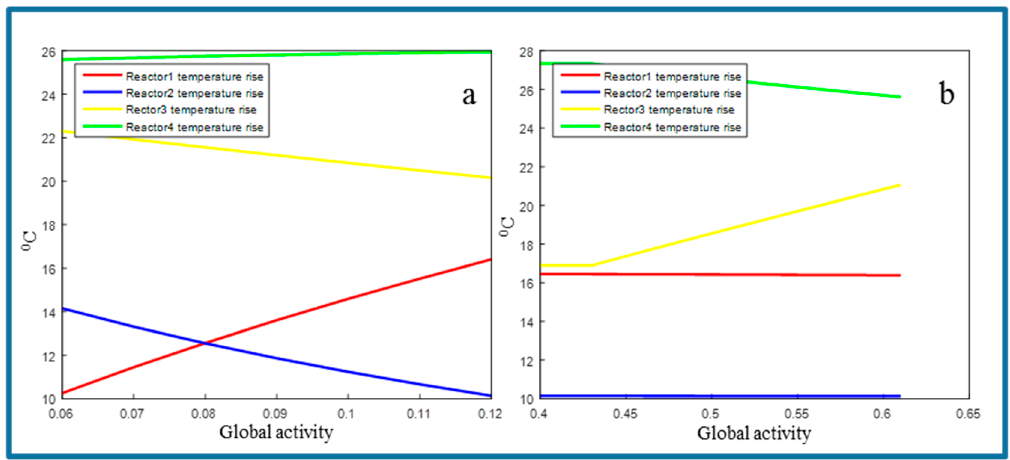
Figure 8. Four reactor temperature rises with global activity of different reactors: ( a ) reactor 1; ( b ) reactor 3.